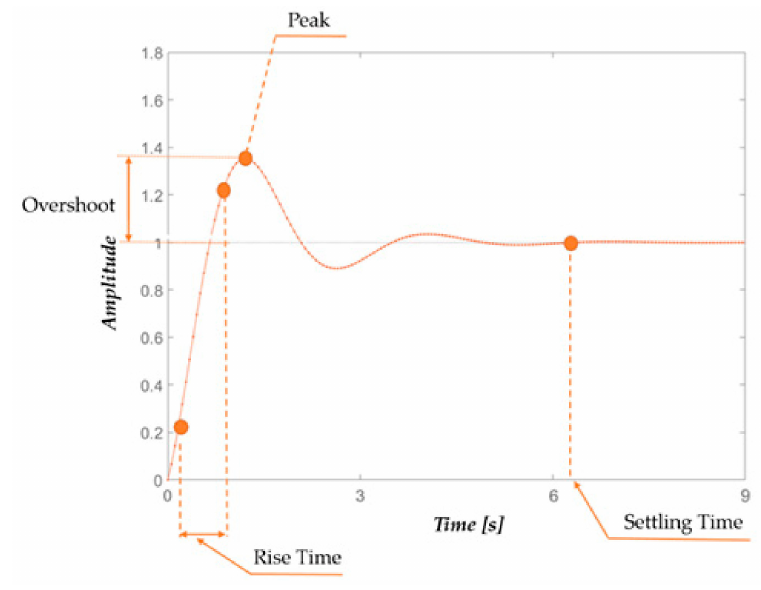
Figure 6. Step response of the PD controller with the PID